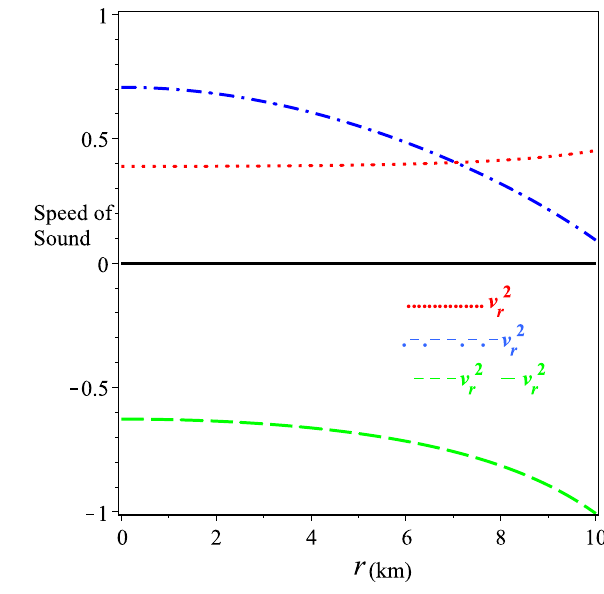
Fig. 4 Plots of the density gradient, radial and tangential pressures of solution (26) versus the radial coordinate r in Km using the PSR J 1614-2230 constraints